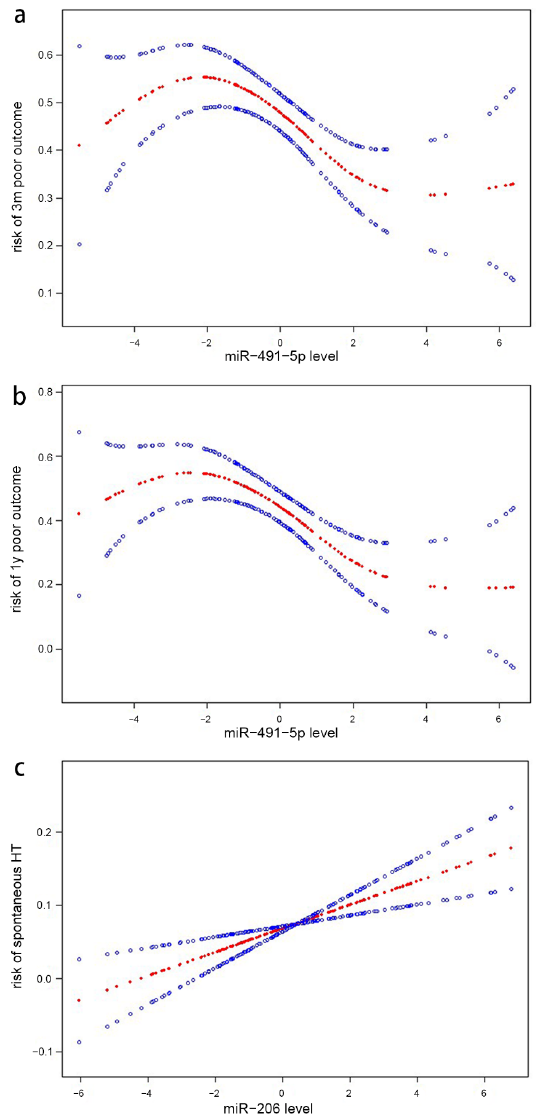
Figure 2. Generalized addictive model (GAM) showed ( a ) the nonlinear correlation between miR − 491 − 5p level and risk of 3-month poor outcome; ( b ) the nonlinear correlation between miR − 491 − 5p level and risk of 1 − year poor outcome; ( c ) approximate linear correlation between miR − 206 level and risk of spontaneous HT. Red lines stand for odds ratios and blue lines stand for their 95% confidence intervals (CI). The miRNA levels were incorporated into the model as Ln − transformed values of fold difference per μ L of serum. The risk of outcomes were calculated and incorporated into the model as Lg(odds ratio). Odds ratios were adjusted for the same variables as model 2 in Table 2 ( a , b ) or model 3 in Table 3 ( c